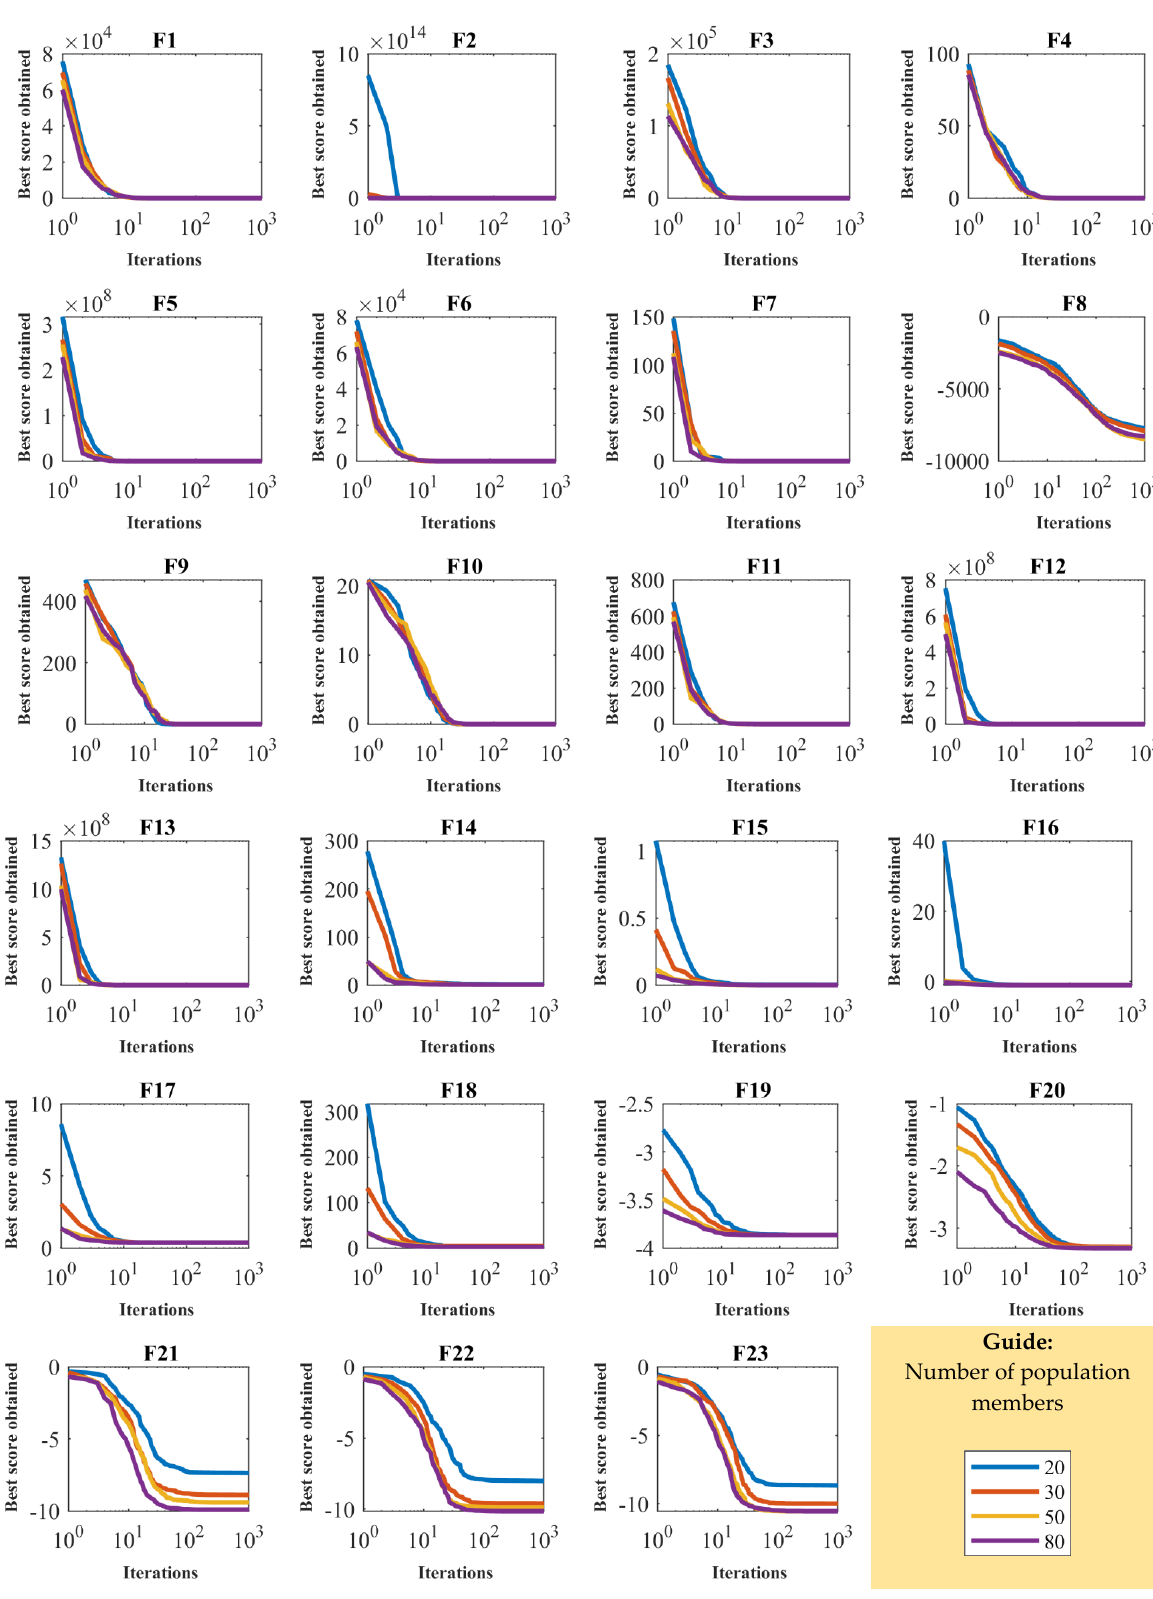
Figure 3. Sensitivity analysis of the POA to N parameter.